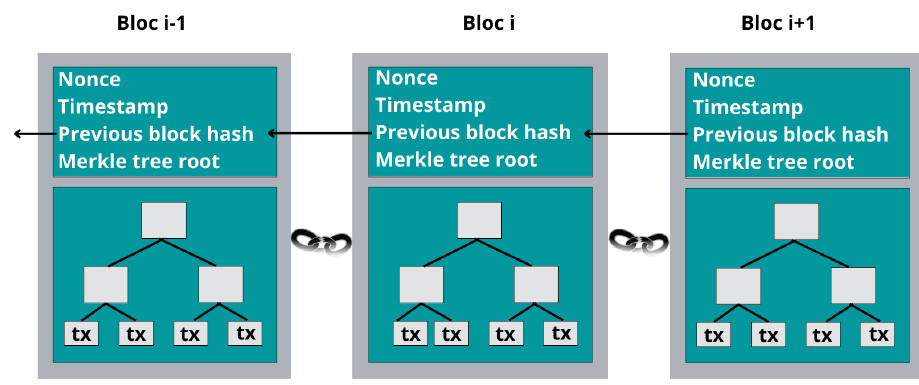
Figure 1. Storage of blocks in a